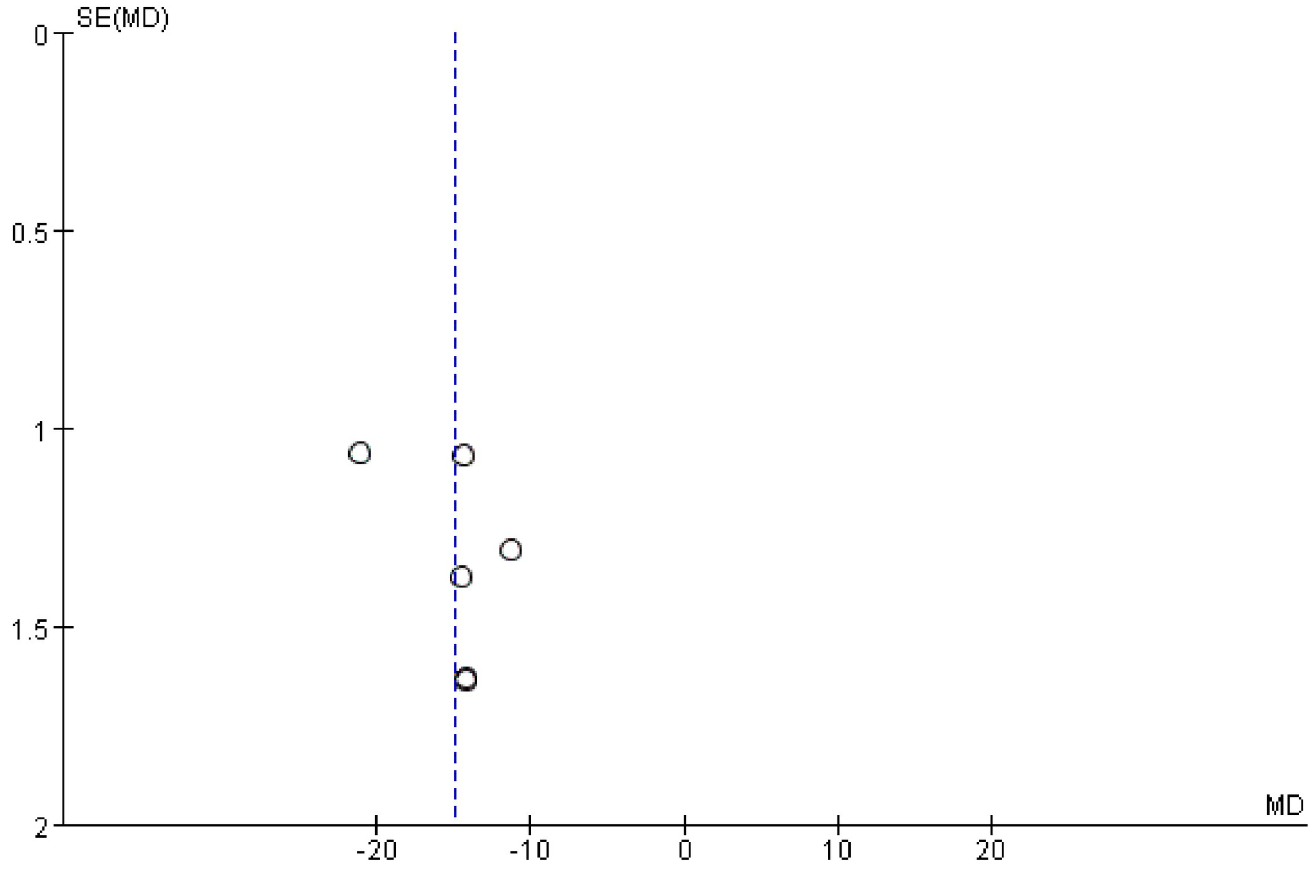
Fig 5. Funnel plot of behavioral